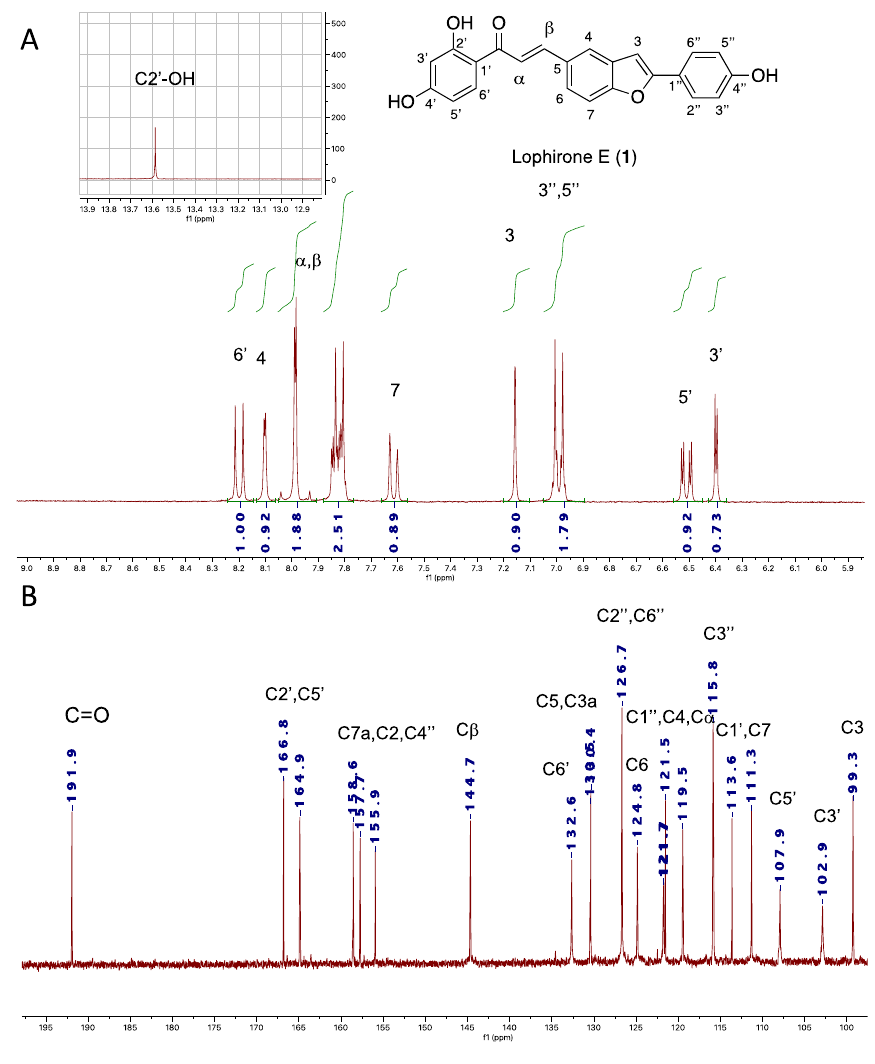
Figure 3. 1 H NMR ( A ) and 13 C NMR ( B ) of lophirone E ( 1 Figure 3. 1 H NMR (A) and 13 C NMR (B) of lophirone E ( 1 ).